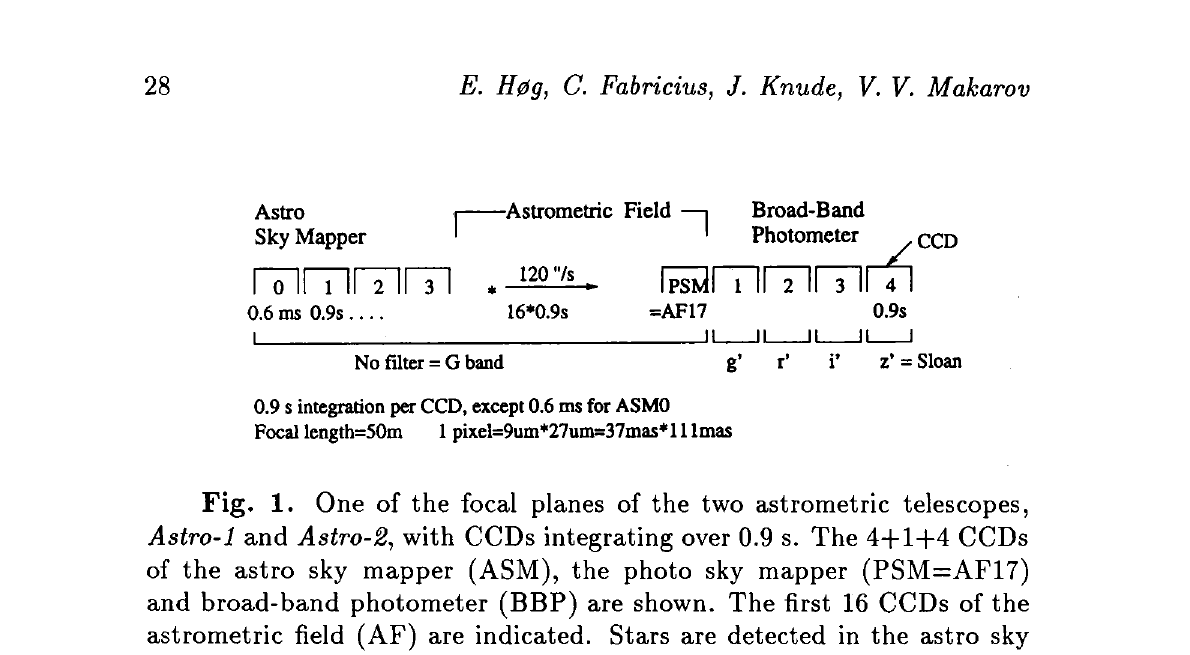
Fig. 1. One of the focal planes of the two astrometric telescopes, Astro-1 and Astro-2, with CCDs integrating over 0.9 s. The 4 + 1 +4 CCDs of the astro sky mapper (ASM), the photo sky mapper (PSM=AF17) and broad-band photometer (BBP) are shown. The first 16 CCDs of the astrometric field (AF) are indicated. Stars are detected in the astro sky mapper and then measured astrometrically 16 times. The PSM will collect samples for a mapping of the vicinity of the detected star within a radius of 1 as. Photometry is obtained through color filters in the BBP giving four-color photometry in each of the two astrometric